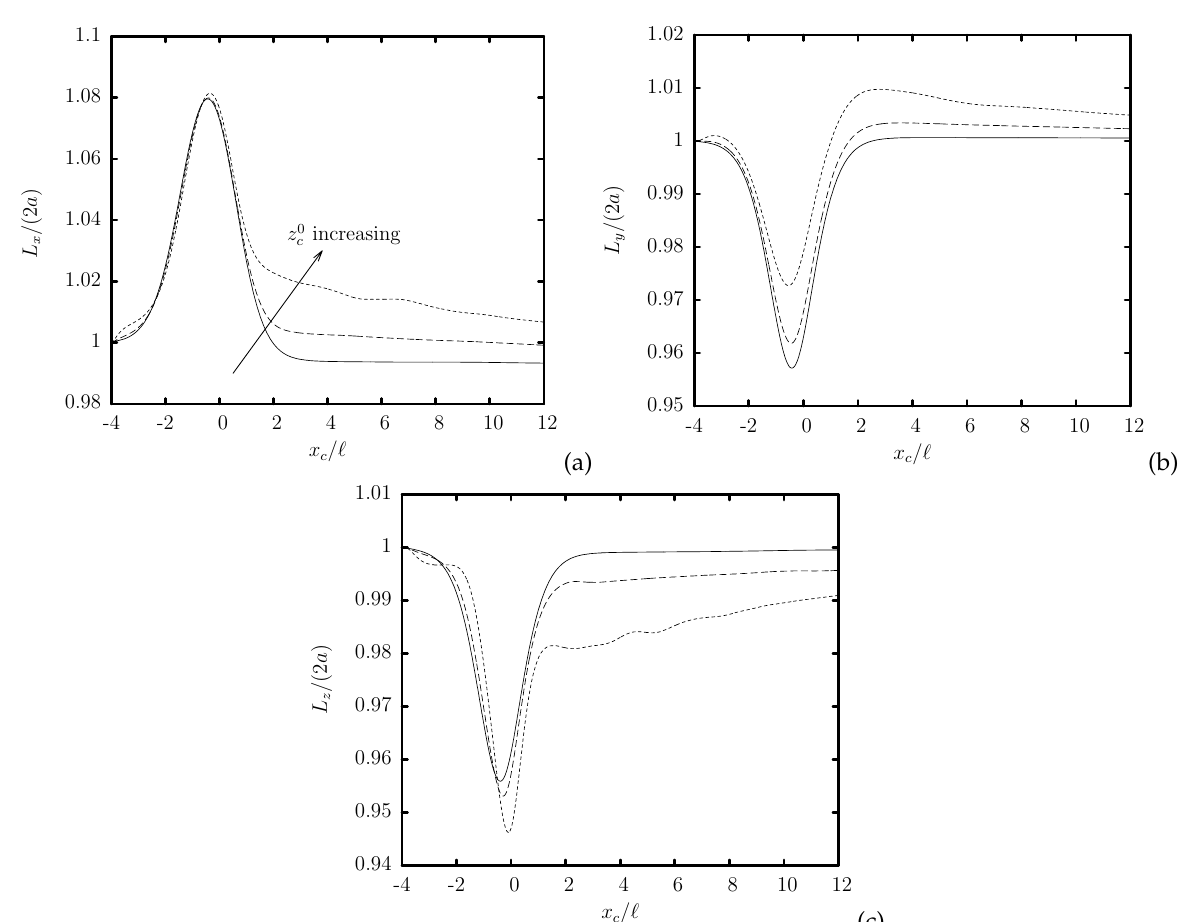
Figure 4. The capsule lengths as a function of the centroid x c , for a Skalak capsule with a / (cid:96) = 0.8, Ca = 0.1, C = 1, λ = 1 and initial position z 0 c / (cid:96) = 0.2,0.5,0.8. ( a ) Length L x , ( b ) width L y and ( c ) height L z .